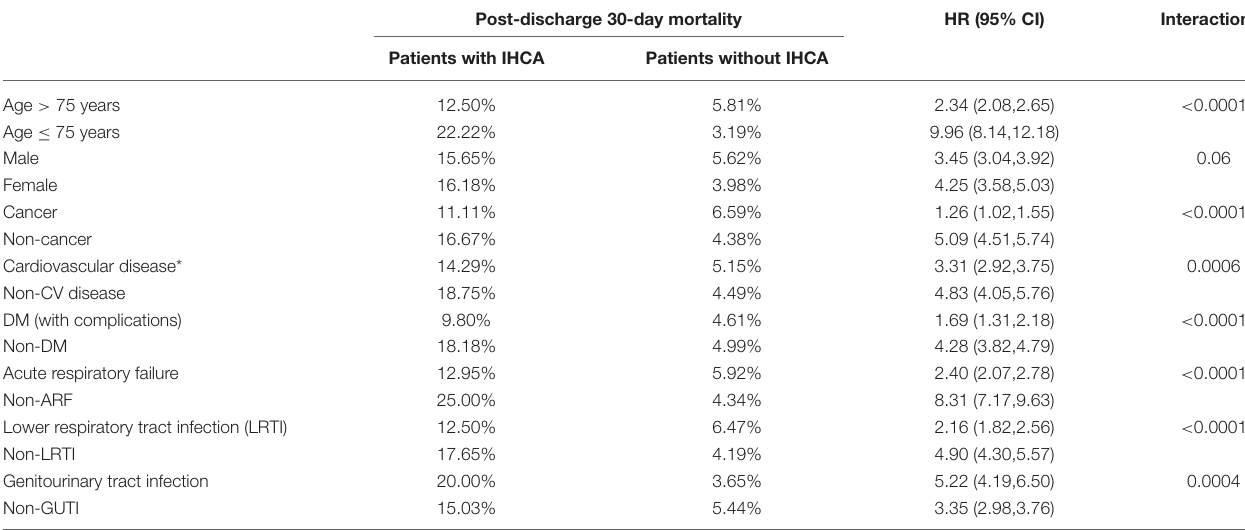
TABLE 4 | Subgroup analysis for post-discharge 30-day mortality among sepsis